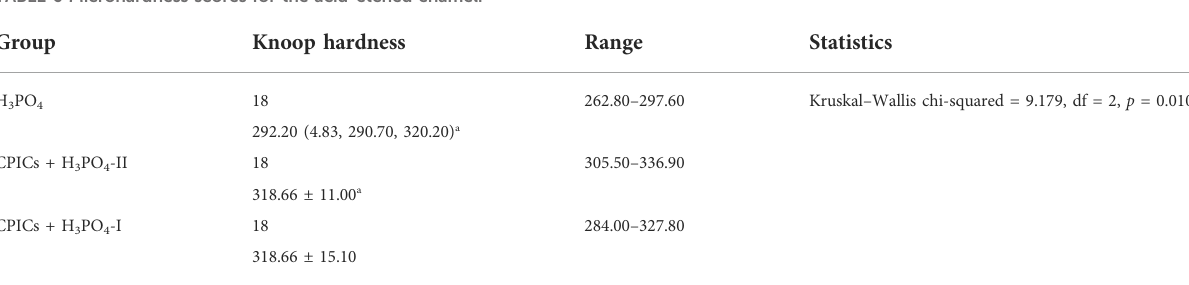
TABLE 6 Microhardness scores for the acid-etched enamel.